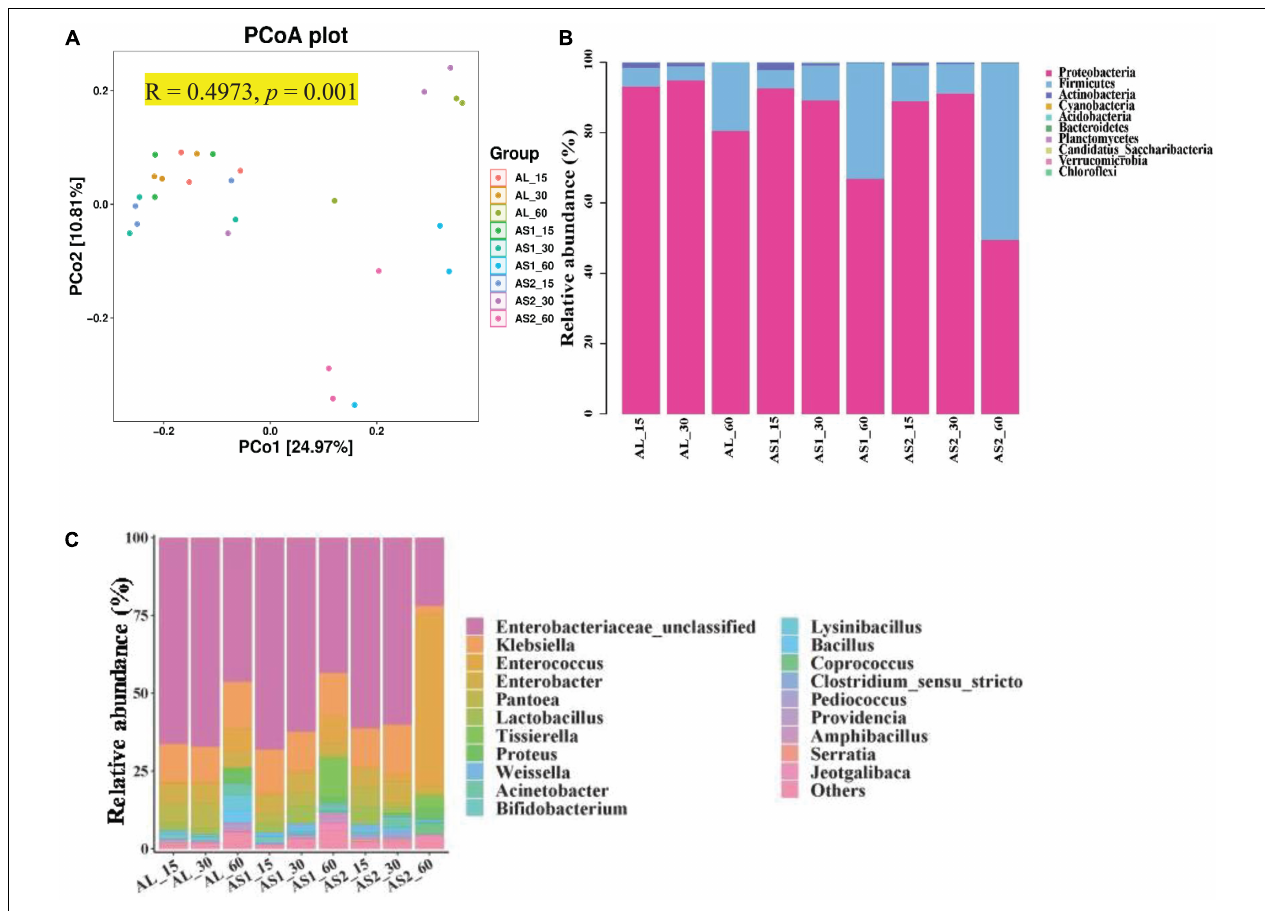
FIGURE 1 | (A) Principal coordinate analysis (PCoA). (B) Relative abundance of microbiota at the level of phylum in the alfalfa silage samples. (C) Relative abundance of microbiota at the level of